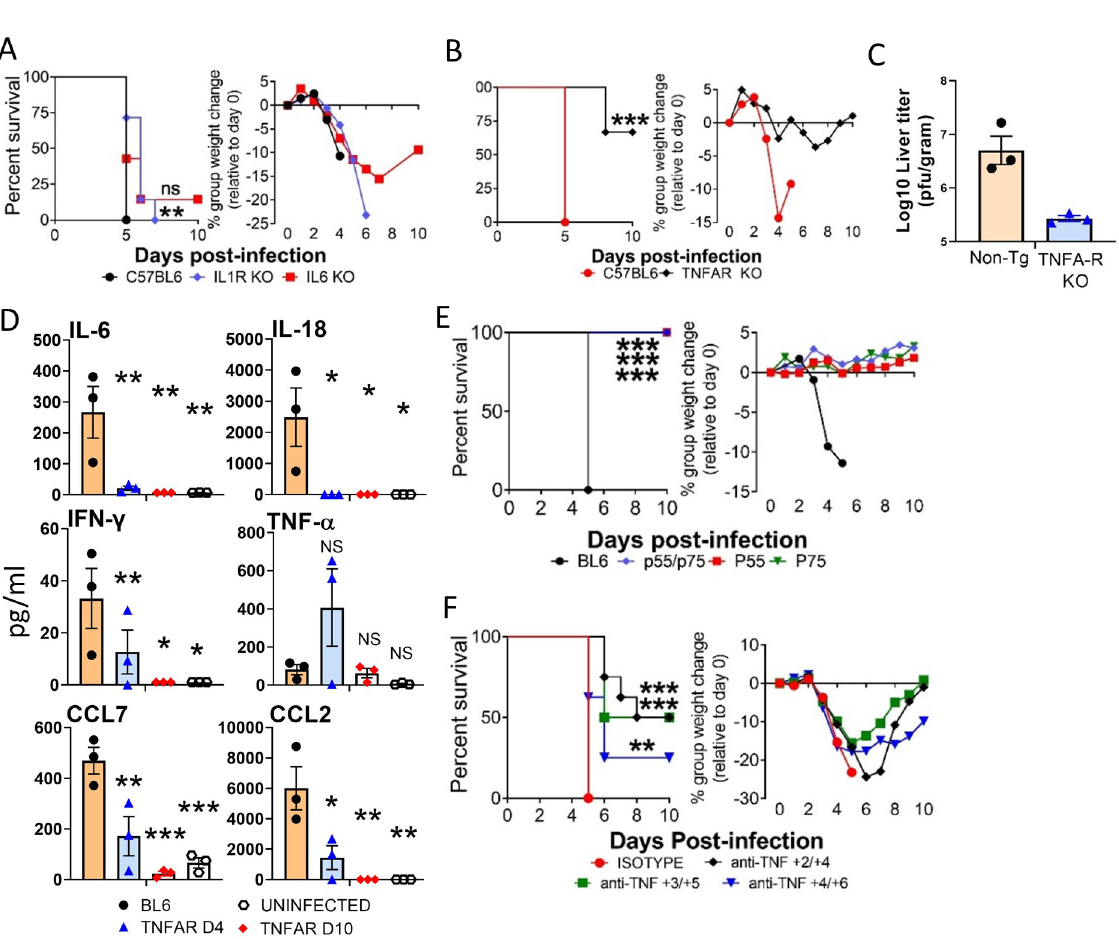
Fig 4. Mice lacking TNFA-R signaling are partially protected against CCHFV. A. WT (C57BL/6), IL-1R KO and IL-6 KO mice (n = 5 per group) were infected with CCHFV and survival and weight loss were monitored as above. Mice were treated with MAb-5A3 24h after infection to block IFN-I. Significance in time to death was determined by log-rank analysis; �� p < 0.05. NS: not significant. B . WT (C57BL/6) or TNFA-R DBL KO mice (n = 6 per group) mice were infected with CCHFV and injected with MAb-5A3 a day after challenge. Weights and survival were monitored for 10 days post-infection. Significance in survival and the delay in time to death was determined by log-rank analysis; ��� p < 0.0001. C. Viral load in day 4 livers was quantified by plaque assay (n = 3 per group). Dashed line shows the limit of detection. D . Monocyte chemoattractants and inflammatory cytokines were measured from the serum of uninfected mice or CCHFV infected WT (BL6) or TNFA-R DBL KO mice (n = 3 per group) mice on day 4 (BL6 and TNFA-R DBL KO mice) and 10 (TNFA-R DBL KO mice) using a multiplex system. Statistical significance compared to infected controls was determined by one-way ANOVA; � p < 0.05, �� p < 0.01, ��� p < 0.001. E. C57BL/6, TNFA-R DBL KO or mice lacking either TNF receptor (p55 or p75) mice (n = 8 per group) were infected with CCHFV and injected with MAb-5A3 as above. Weights and survival were monitored for 10 days post-infection. Survival significance versus C57BL/6 wild-type mice was determined by log-rank analysis; ��� p < 0.0001. F. C57BL/6 (n = 8 per group) were infected with CCHFV and IFN-I antibody blockade was established 24 h post-infection as above. Mice were treated with anti-TNF- α neutralizing antibody or isotype control as indicated. Weights and survival were monitored for 10 days post-infection. Significance of delay in time to death and overall increase in survival compared to isotype control animals was determined by log-rank analysis; �� p < 0.05, ��� p < 0.0001.